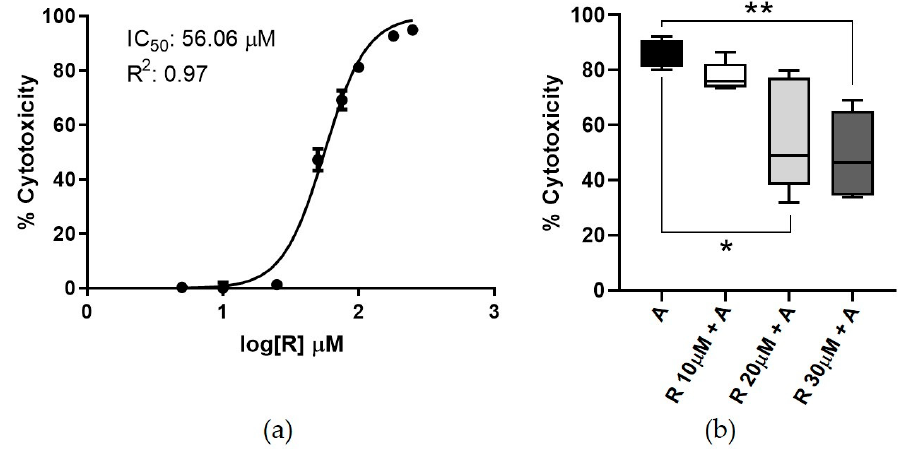
Figure 1. Cytotoxicity. ( a ) Resveratrol dose–response curve in BFH12 cells (64 h), based on three independent cell culture experiments, each one run in sextuplicate. Data are expressed in mean cytotoxicity rate ± standard error of the mean (SEM). IC 50 and R 2 are also reported. ( b ) AFB1 cytotoxicity in presence of R (16 + 48 h). The box and whiskers plots report the viability of BFH12 cells pre-treated with R increasing concentrations (10, 20, and 30 µ M) and exposed for 48 h to a combination of AFB1 3.6 µ M and R (same concentration reported above). ** p ≤ 0.01, * p ≤ 0.05 (Kruskal–Wallis and Dunn’s multicomparisons tests; the mean of each condition was compared with the mean of the AFB1 condition). Graphs were obtained by means of GraphPad prism software. R = resveratrol; A = AFB1.